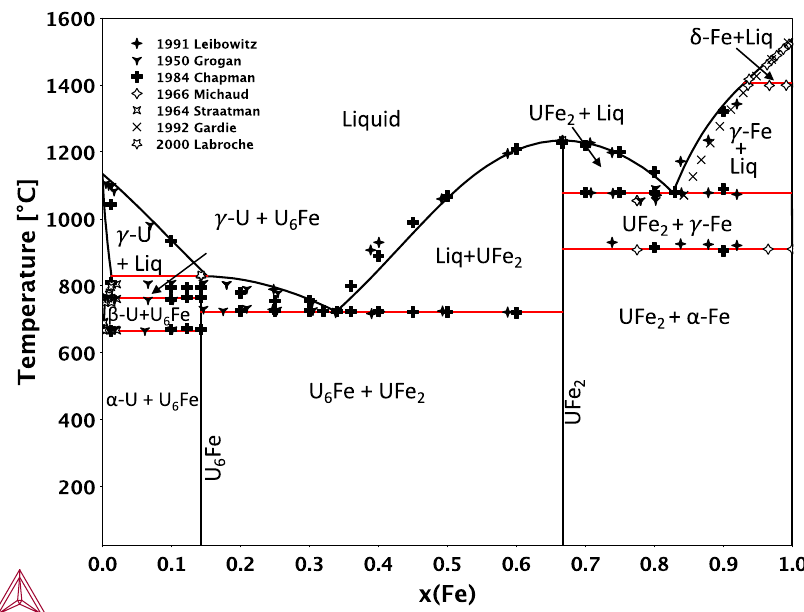
Figure 3. U-Fe phase diagram based on the present CALPHAD assessment compared with selected experimental data [56,58–62,64].